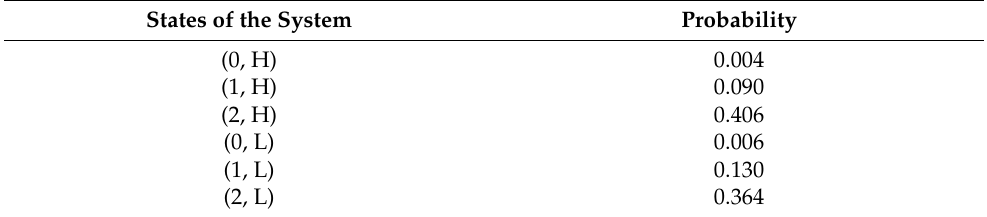
Table 15. Steady state of two active firms.